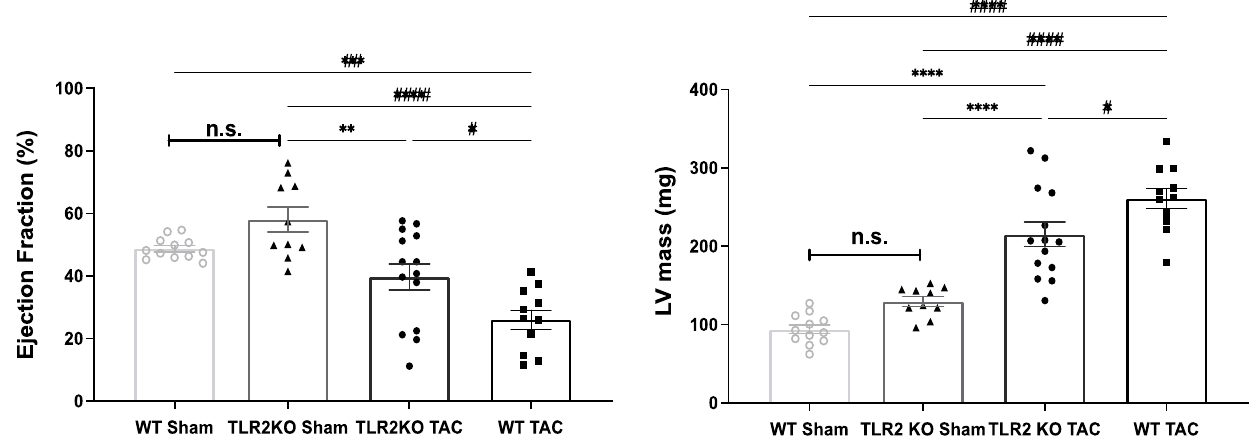
Figure 1. Echocardiographic parameters show no significant differences between WT sham and TLR2 KO sham group. All mice were obtained from Jackson Laboratory (C57BL/6J WT and TLR2 KO mice). WT sham (gray circles) and TLR2 KO sham (triangles) groups are comparable in their ejection fraction (%) and left ventricular mass (LVmass) (mg) measured by echocardiography after 8 and 12 weeks, respectively. Statistics were performed using a one-way ANOVA followed by Tukey’s multiple comparisons test. Black circles represent TLR2 KO TAC animals and black squares WT TAC animals. n.s. = not significant. ** p < 0.01, **** p < 0.0001; # p < 0.005, ## p < 0.01, #### p < 0.0001.